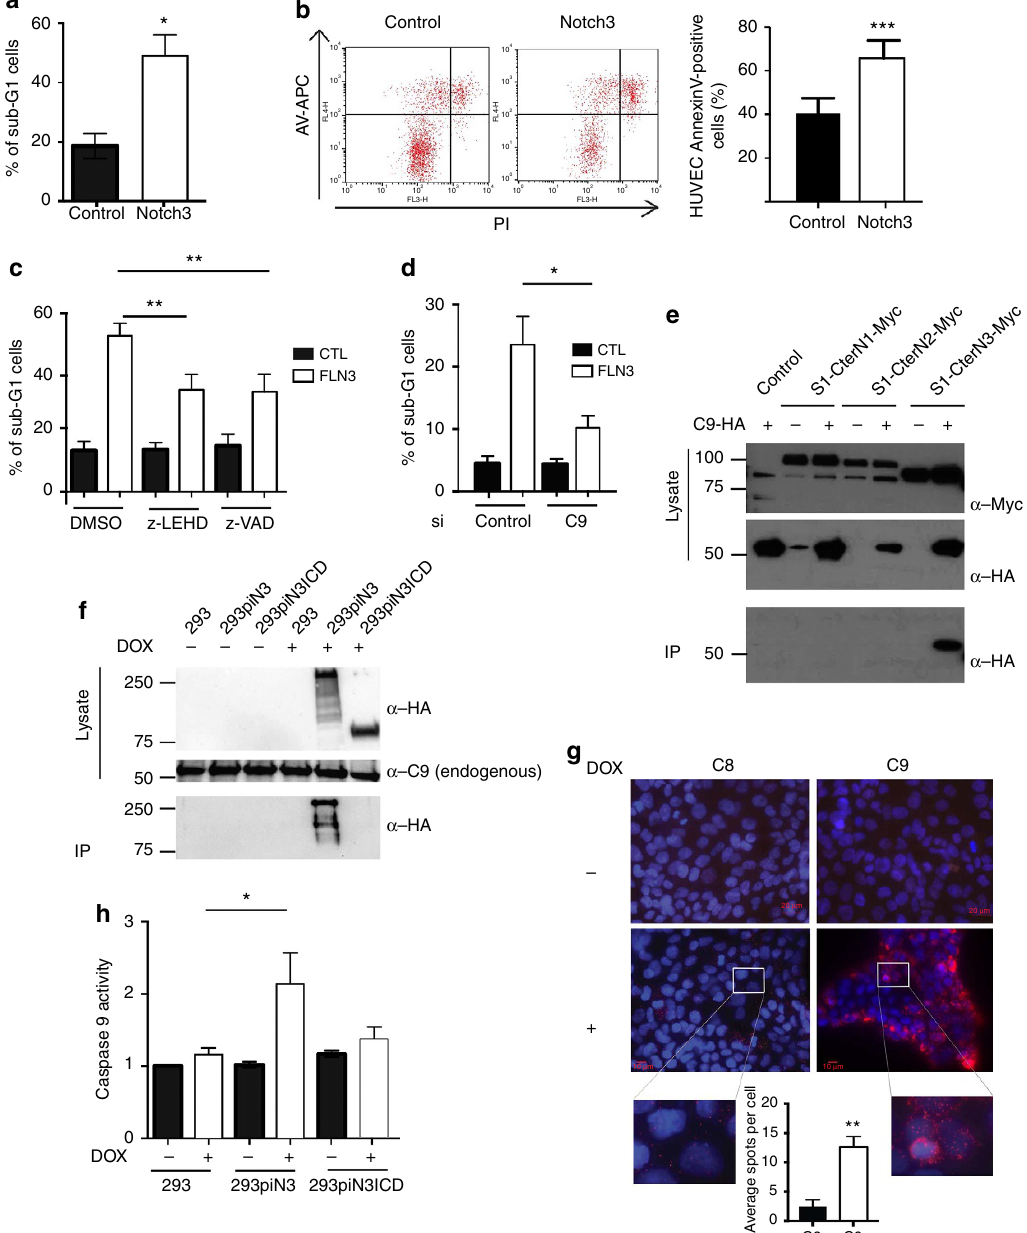
Figure 3 | Notch3 induces endothelial cell death in vitro . ( a ) Sub-G1 analysis of HUVEC electroporated with a control plasmid (Control), or a plasmid expressing the full-length version of Notch3 for 24h. Quantification was made for three independent experiments and a paired-ratio t -test was